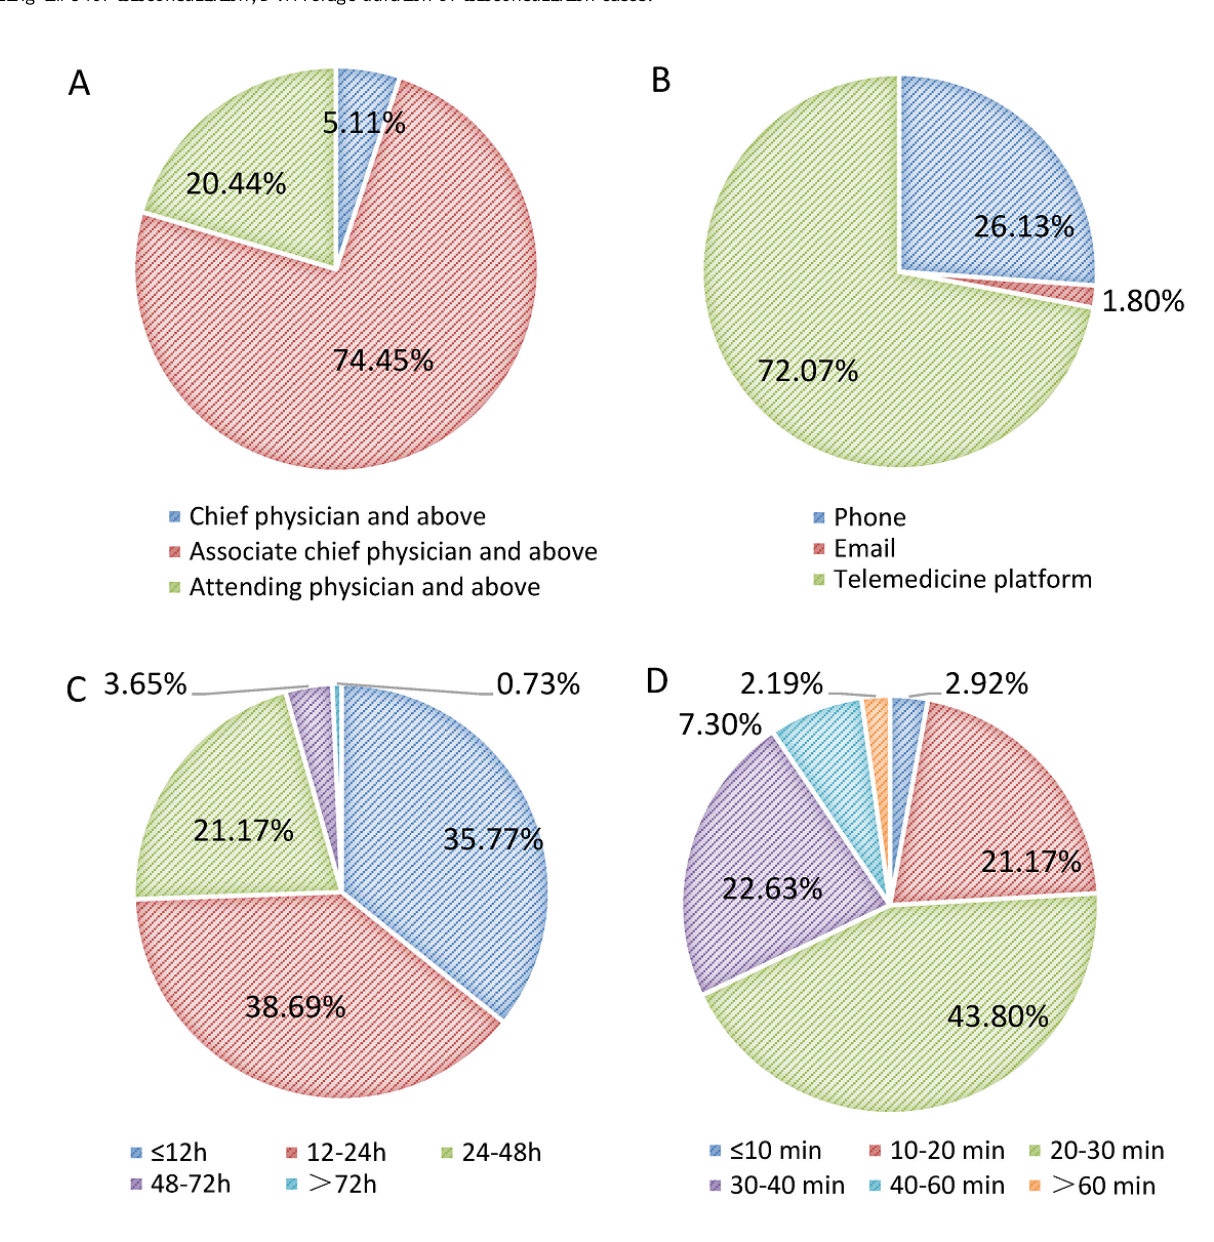
Figure 8. Teleconsultation status in tertiary hospitals: A. Levels of teleconsultation specialists; B. Ways to apply for teleconsultation; C. Average waiting time for teleconsultation; D. Average duration of teleconsultation